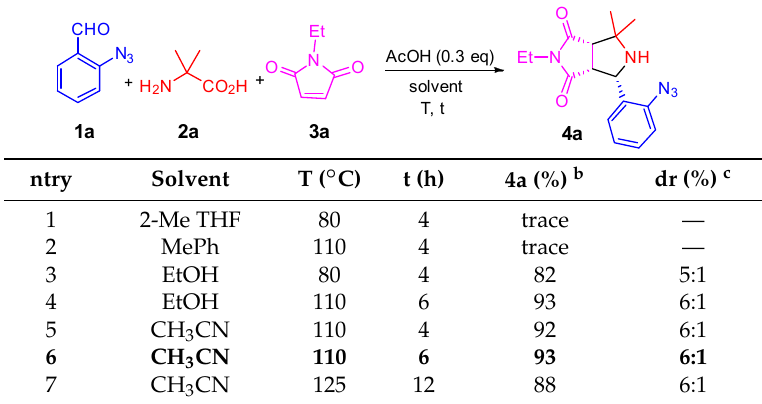
Table 1. Three-component decarboxylative [3 + 2] cycloaddition a .